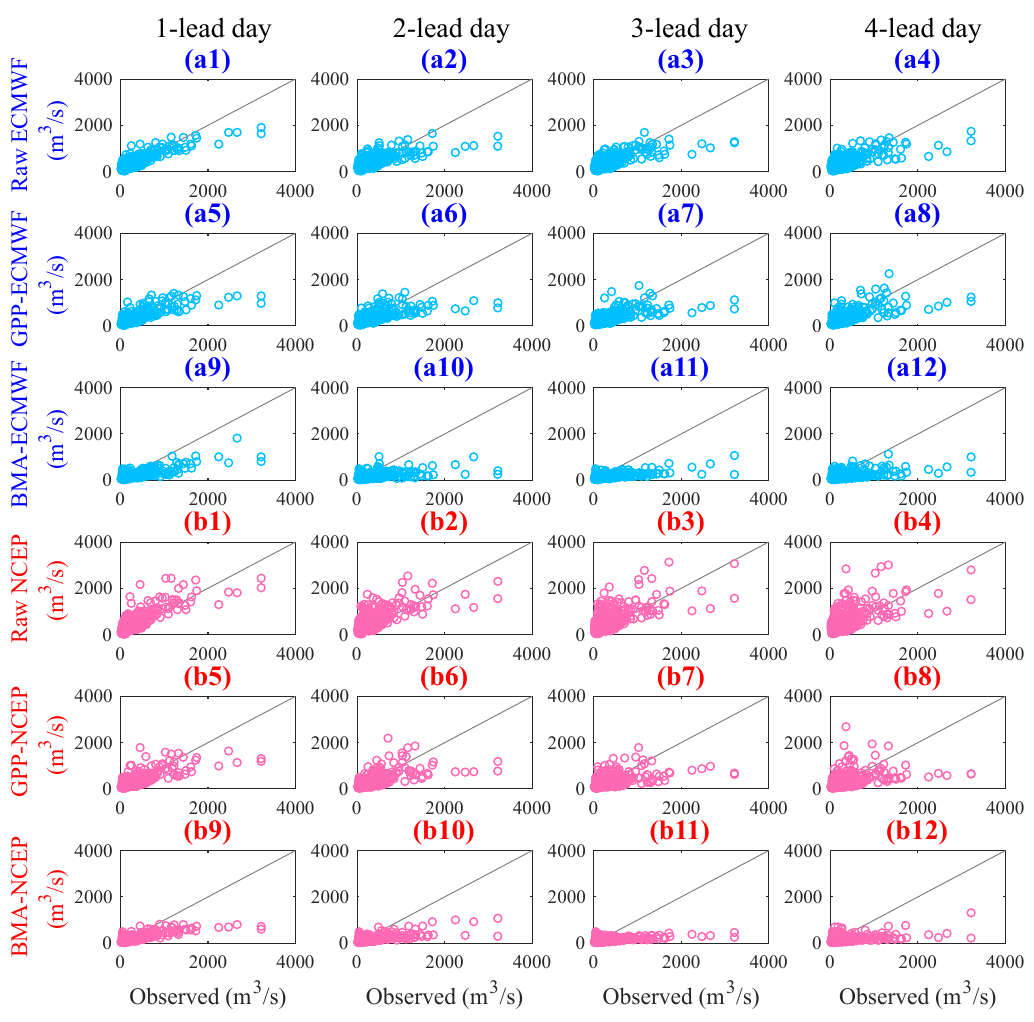
Figure 8. Scatter plots of ensemble mean forecast and observed streamflow during the 2017 period. ( a1 – a12 ) represent ECMWF and ( b1 – b12 ) represent NCEP. Columns 1–4 represent 1, 2, 3, and 4 lead days, respectively.